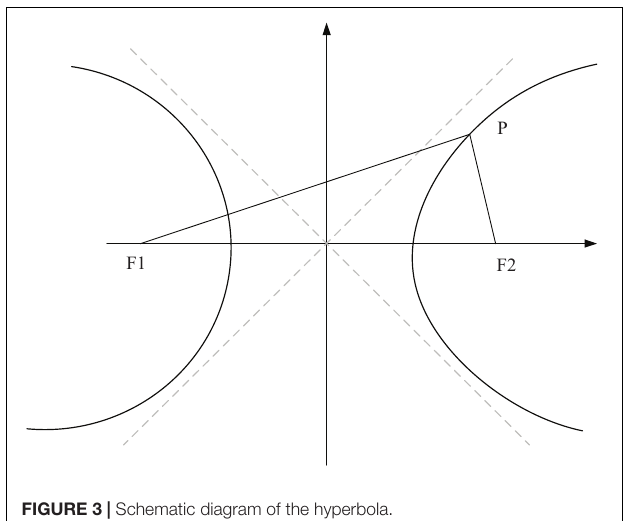
FIGURE 3 | Schematic diagram of the